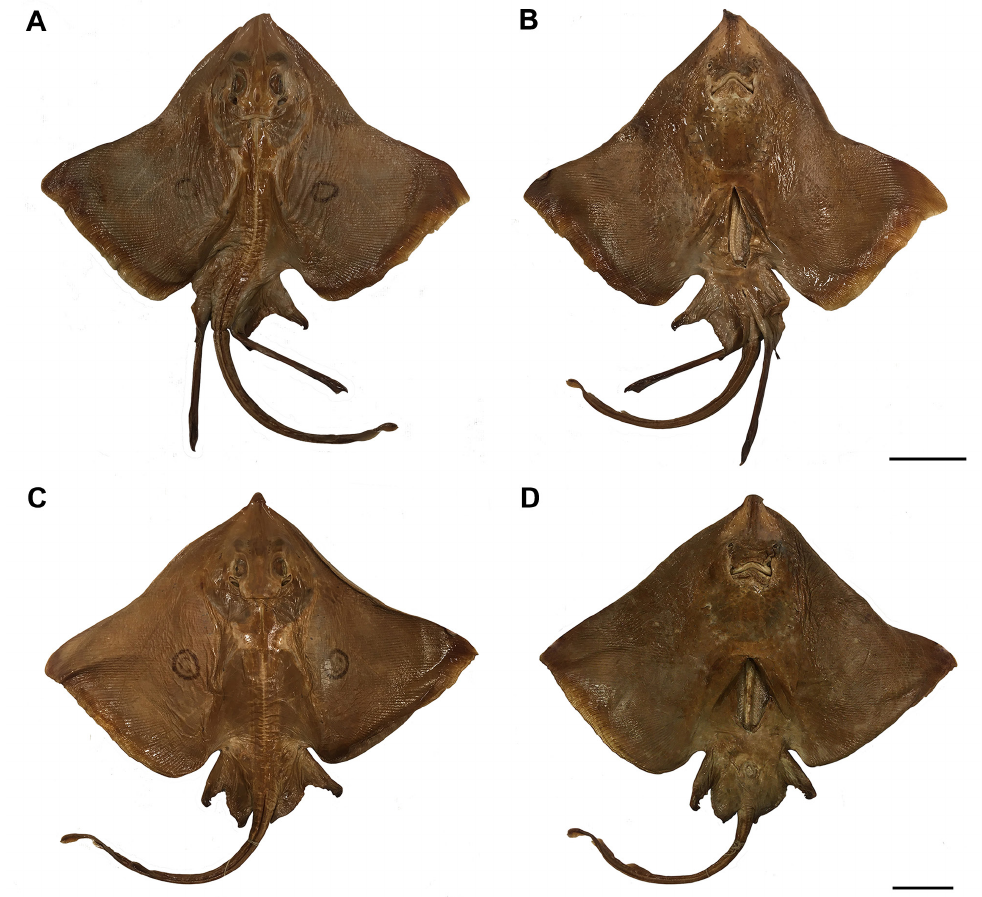
FIGURE 7 | Types of Atlantoraja cyclophora . A , B. BMNH 1903.6.9.134, male, 325 mm DW, lectotype; C , D. BMNH 1903.6.9.135, female, 430 mm DW, paralectotype. Scale bars = 20